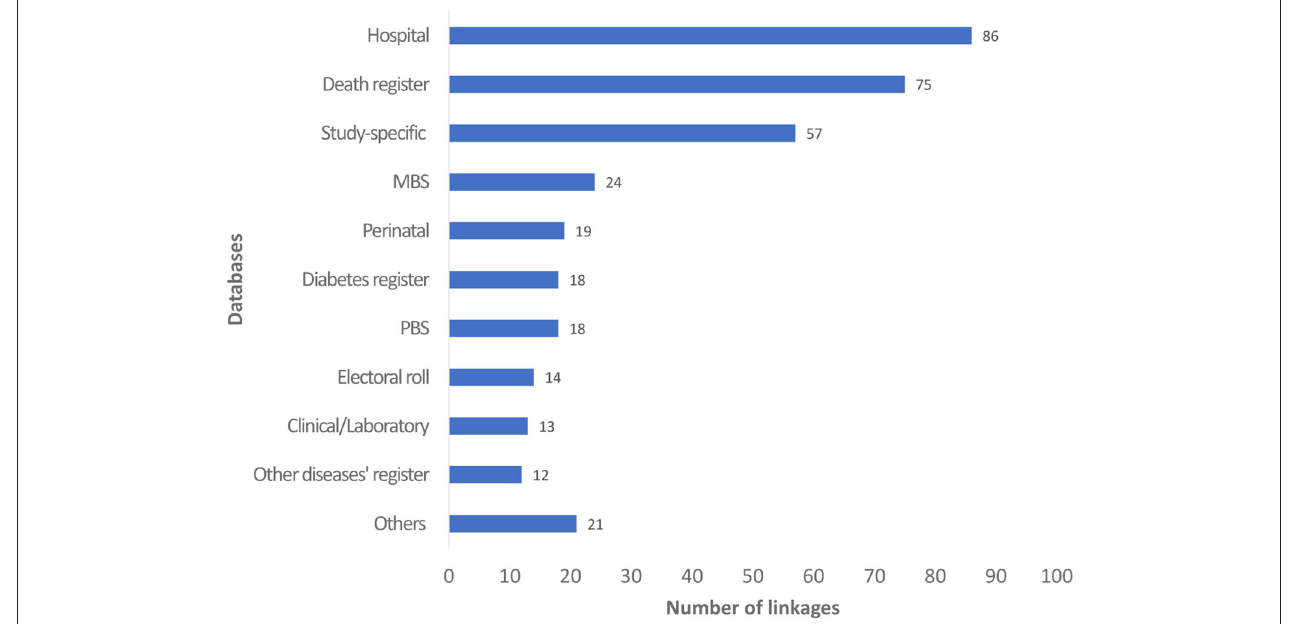
FIGURE 3 | Number of linkages by databases. MBS, Medicare Benefits Schedule; PBS, Pharmaceutical Benefits